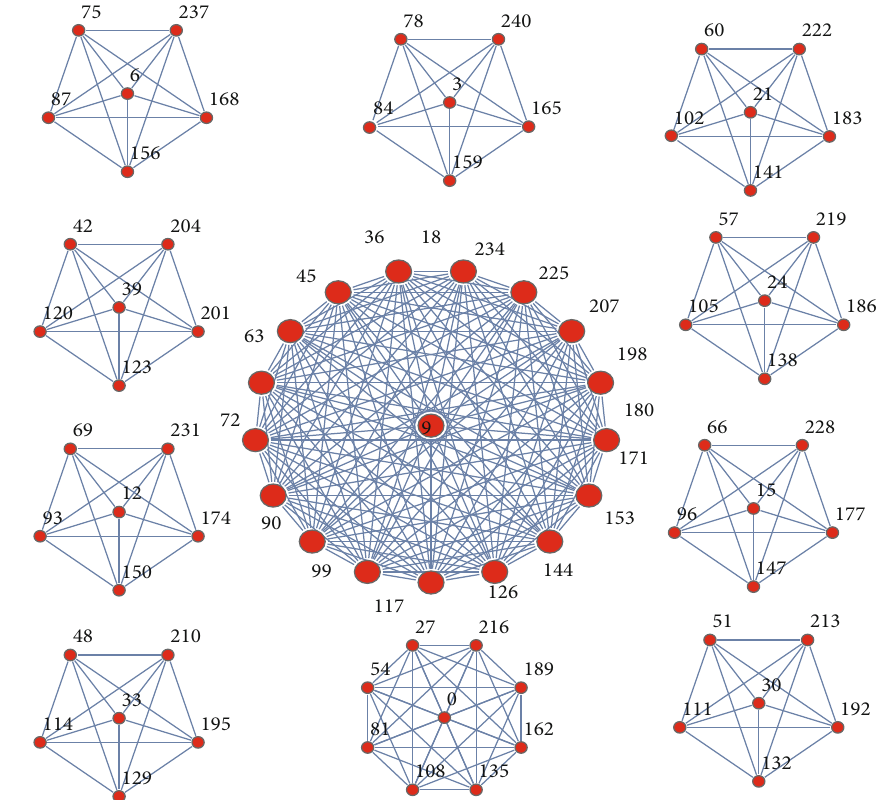
Figure 3: G ð 2,243 Þ = 9 K